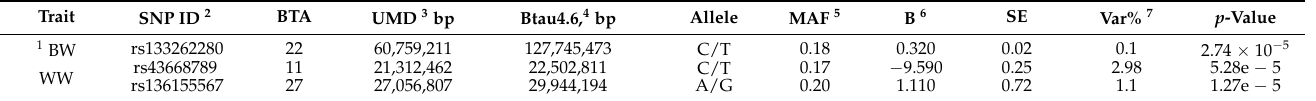
Table 2. Parameters and statistics of SNP associated with liveweight traits of Braunvieh cattle.